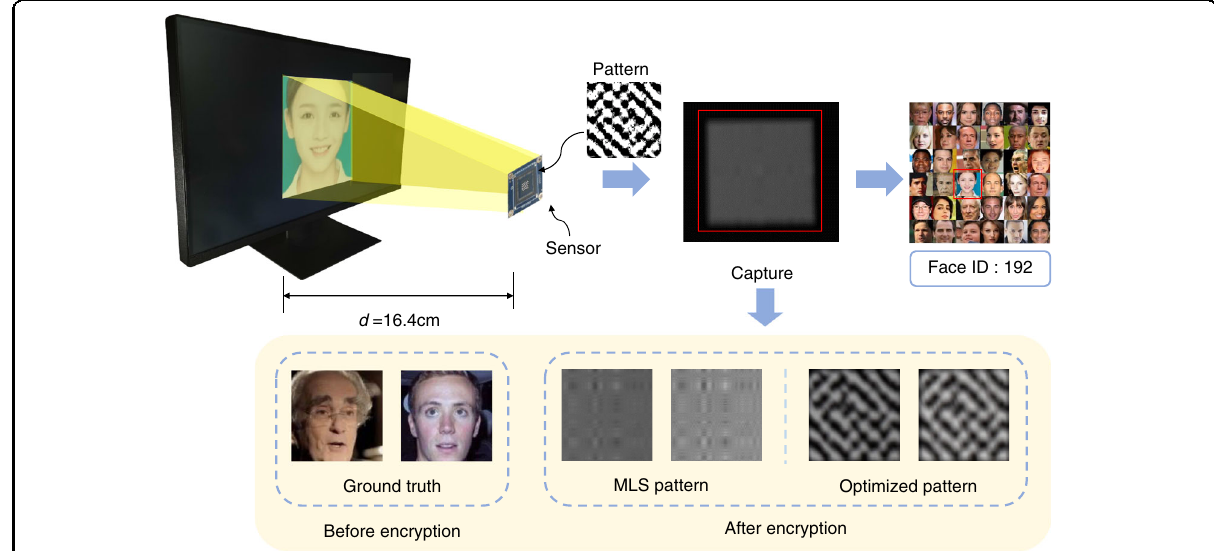
Fig. 10 LOEN prototype for large-kernel system to achieve privacy-protecting face